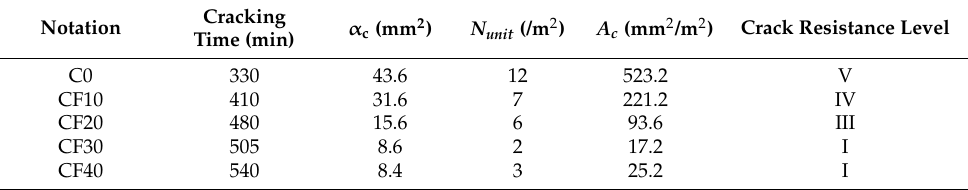
Table 3. The slab test results of face slab concrete with different fly ash